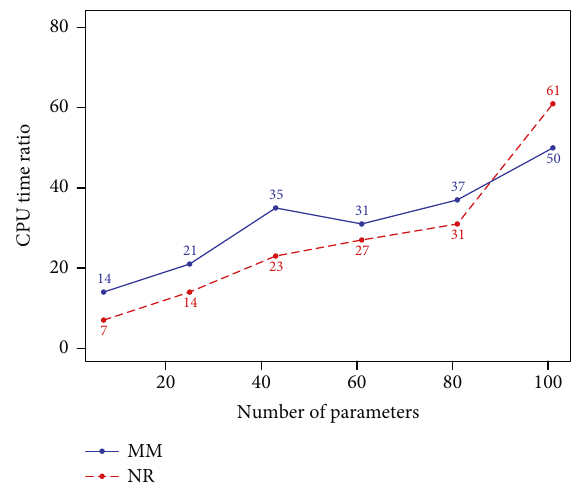
Figure 3: CPU time ratios for NR and MM algorithms ( n = 5000